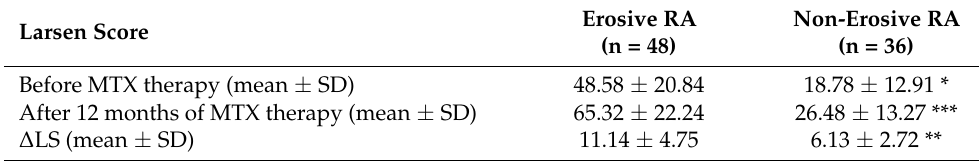
Table 4. Larsen score in patients with RA according to the presence of erosions on radiographs. Larsen